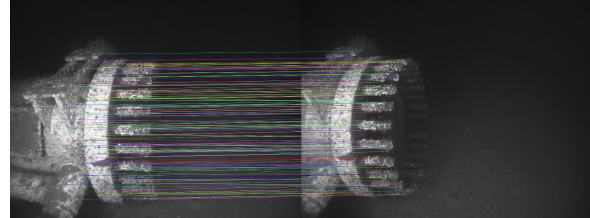
Figure 9. An example of stereo matching using the proposed